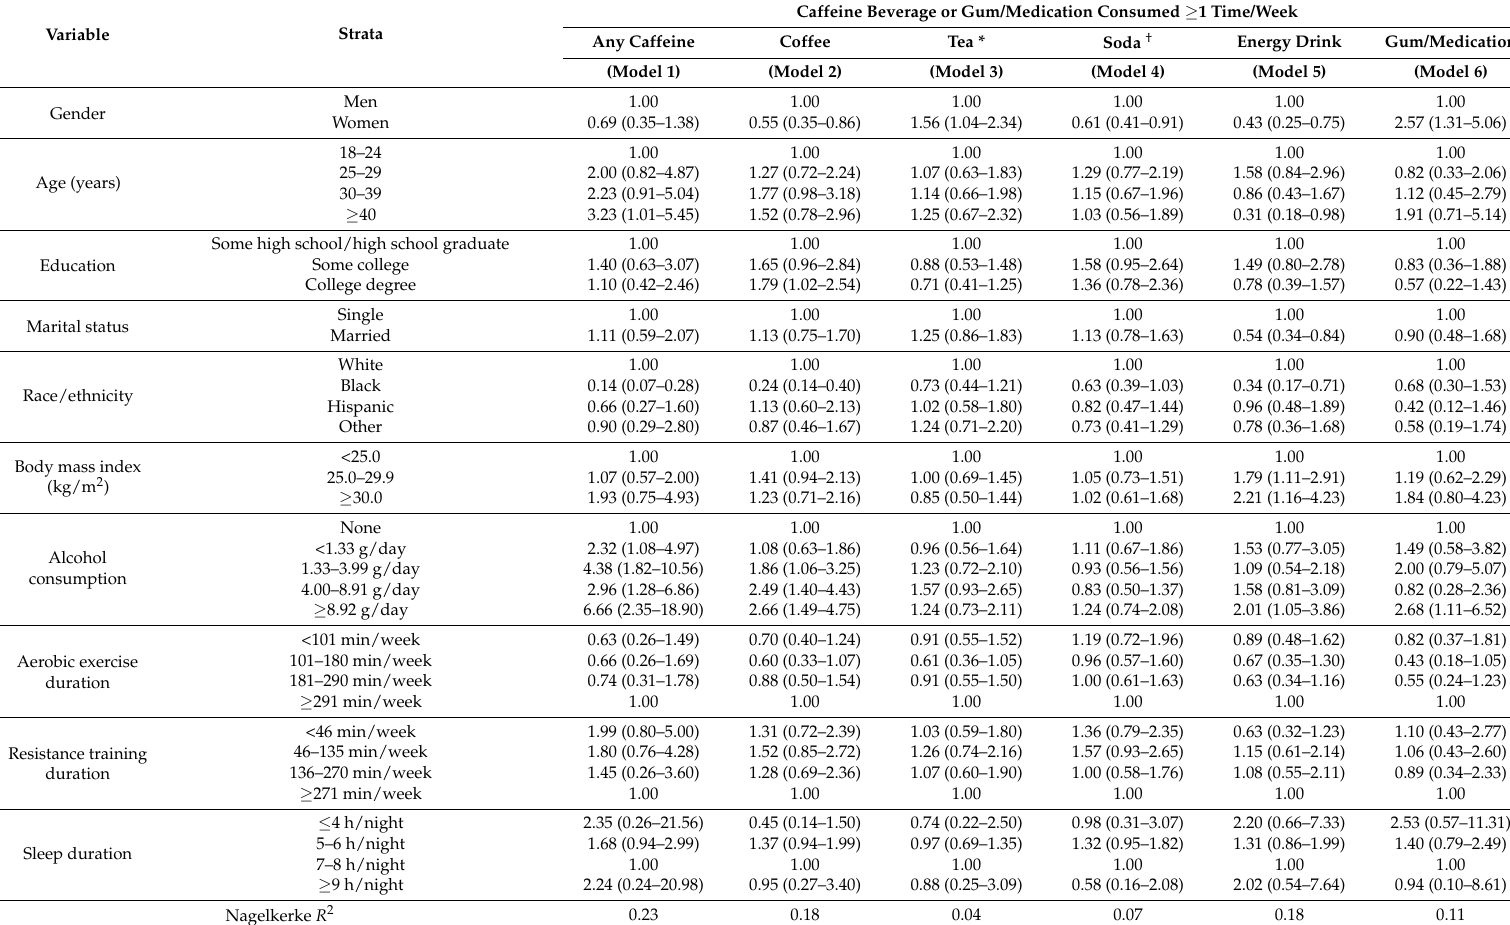
Table 7. Characteristics associated with use ( ≥ 1 time/week) of specific caffeine products among Navy personnel. Multivariable logistic regression was used. Data are presented as odds ratios adjusted for other factors listed with 95% confidence intervals. The odd ratio 1.00 represents the reference group for each